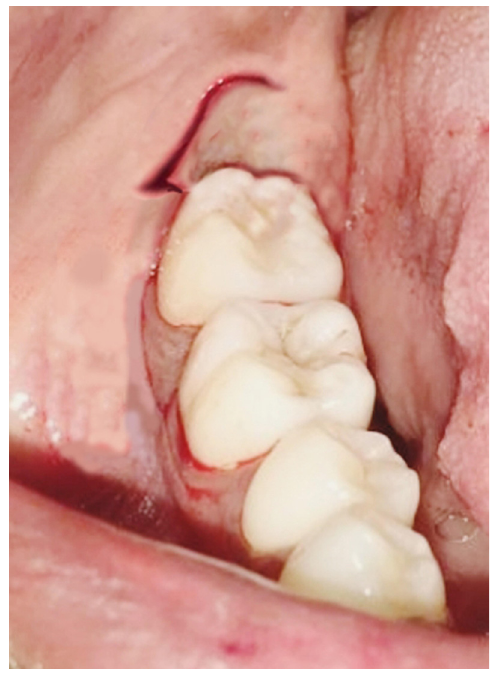
Fig. 3. Surgical incision for lingual based triangular fl